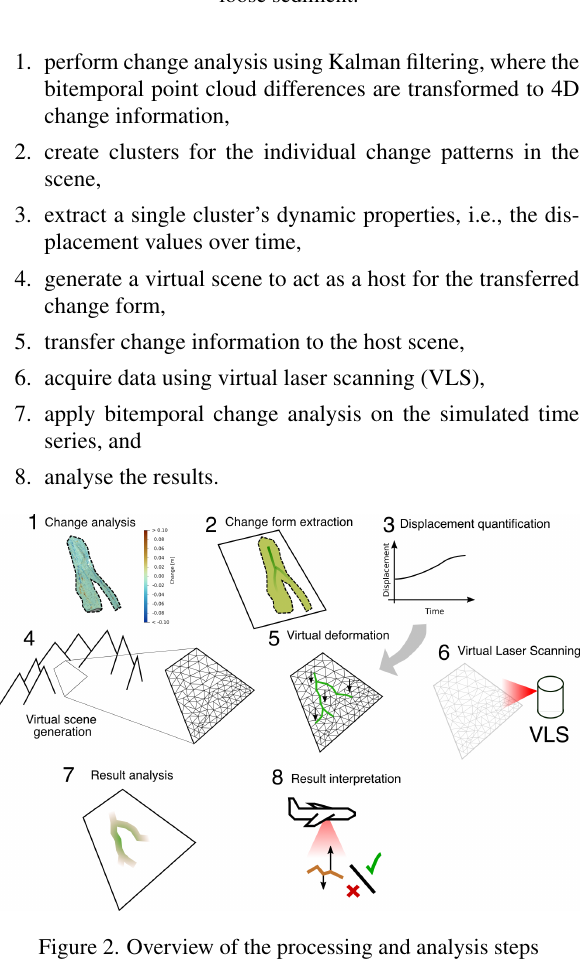
Figure 1. Overview of the TLS dataset of Vals. The rockfall-affected area is in the centre of the dataset, from which we extract erosion rills (marked by the dashed polygon) for transfer to a virtual dataset. The large magnitude changes at the bottom of the slope are caused by excavator works transporting loose sediment.